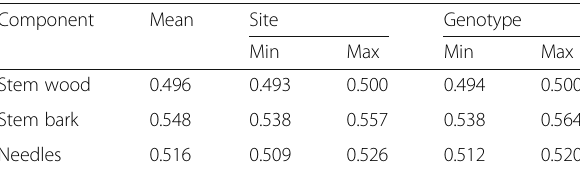
Table 4 Carbon fractions of Douglas-fir biomass components of eight trees from a 10-year-old stand at